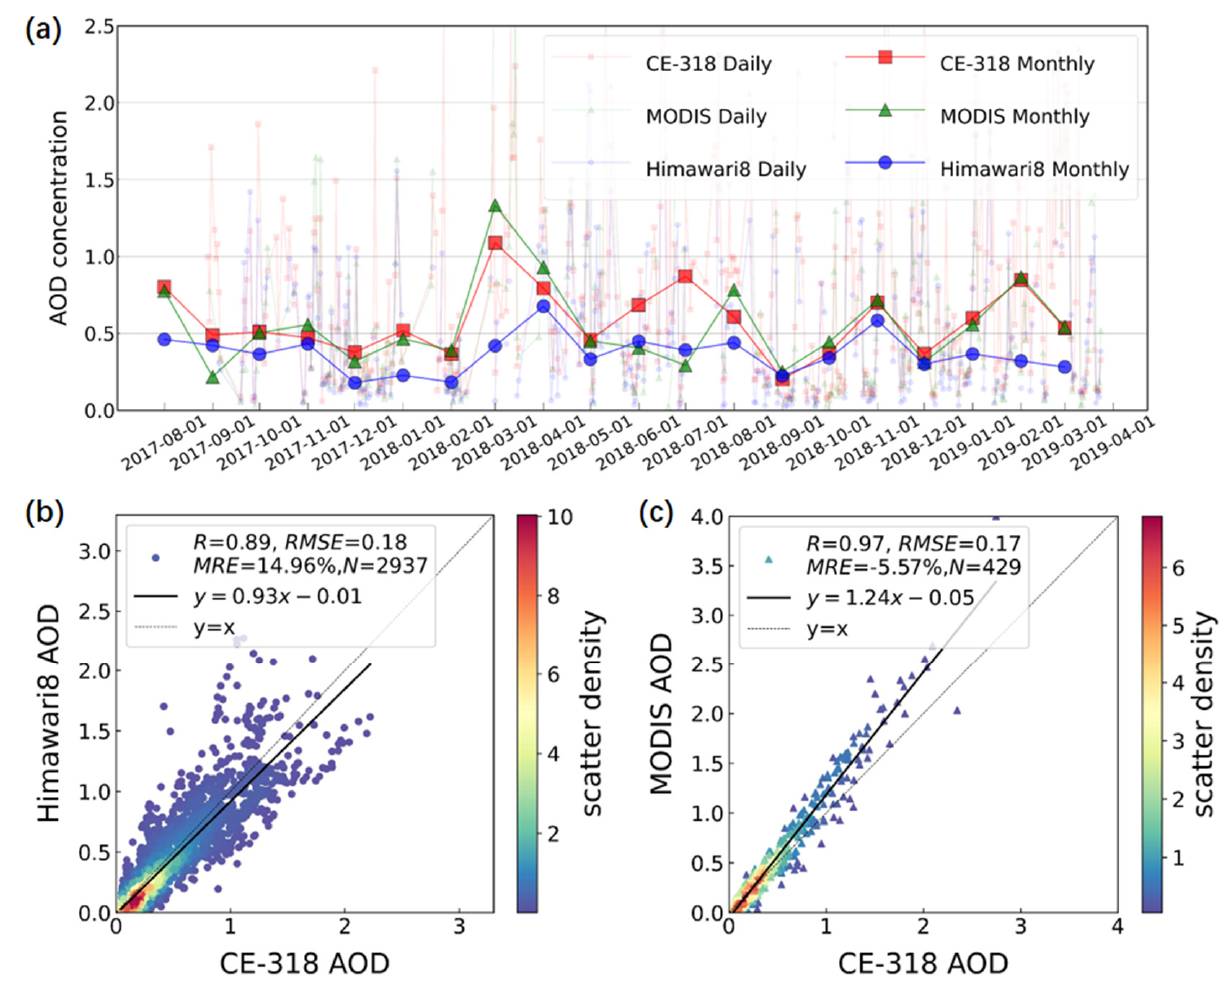
Figure 2. ( a ) Daily and monthly averaged time series of the sun photometer AOD, AHI AOD, and MODIS AOD at the Gucheng site from August 2017 to March 2019. The AHI AOD inversion at 500 nm ( b ) and the MODIS AOD inversion at 470 nm ( c ) were validated by sun photometer AOD at 500 nm at the Gucheng site from August 2017 to March 2019. Note that the original AOD measurements of the sun photometer are matched with collocated satellite ground pixels within a spatial and temporal window in ( b , c ).